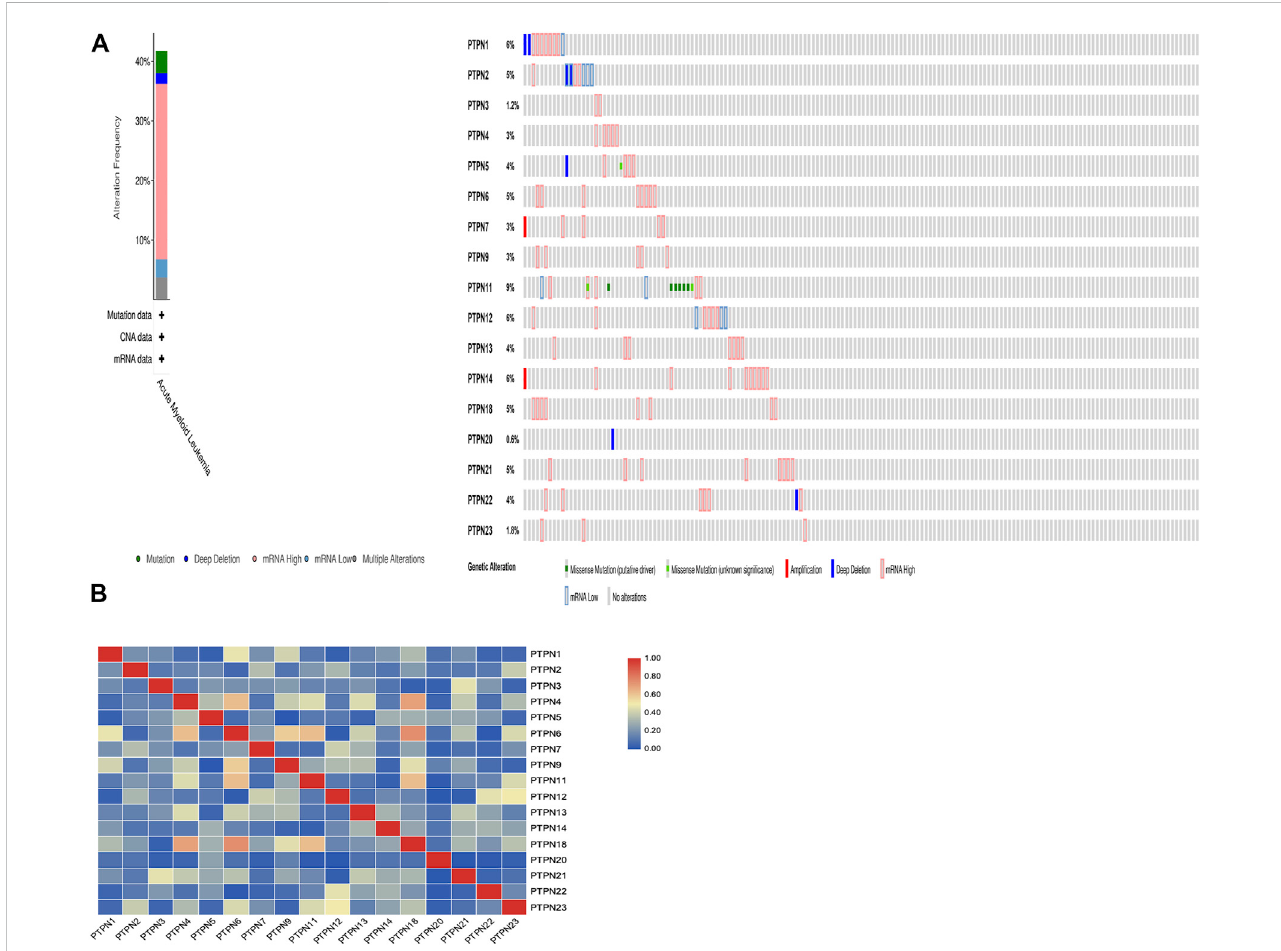
FIGURE 6 Genetic alteration and correlations of PTPN genes in AML. (A) Genetic alteration of PTPN gene in AML. (B) Genetic correlations of PTPN genes in